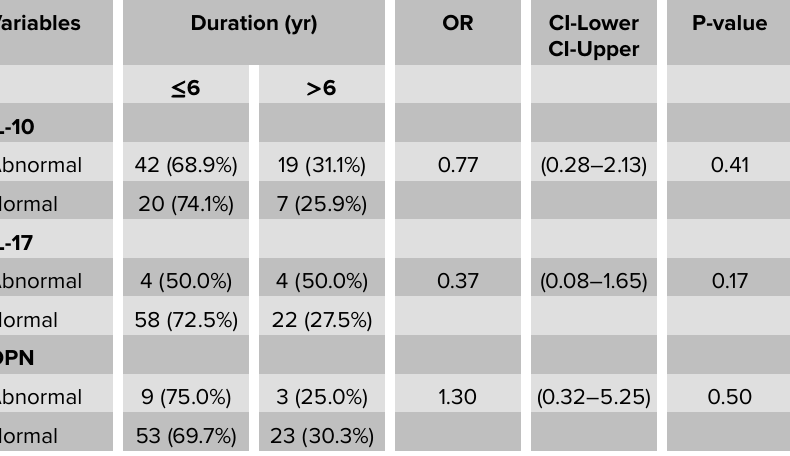
TABLE 3: Association between interleukins IL10, IL17, OPN and duration of RA.